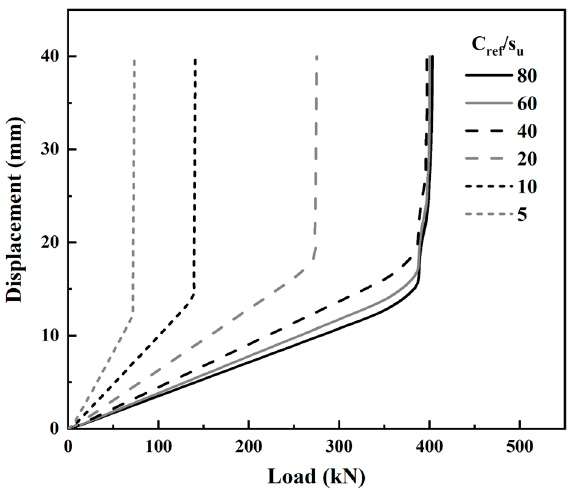
Figure 7. Load–displacement curve of SDCM-1-2 .